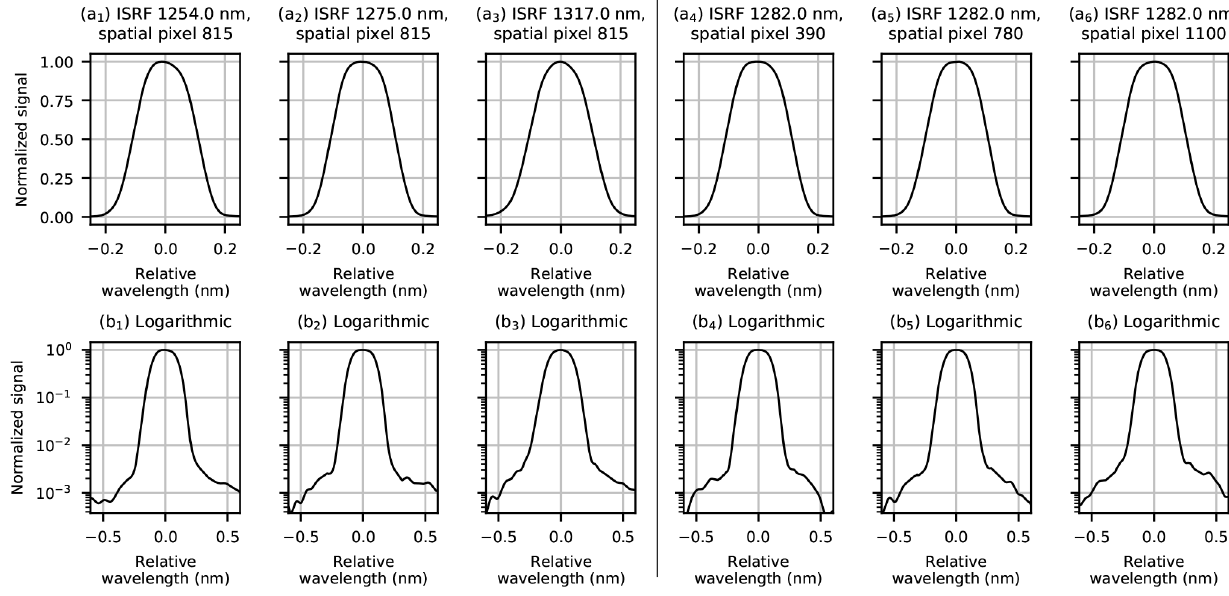
Figure 13. Similar to Fig. 12 but for the O 2 band.